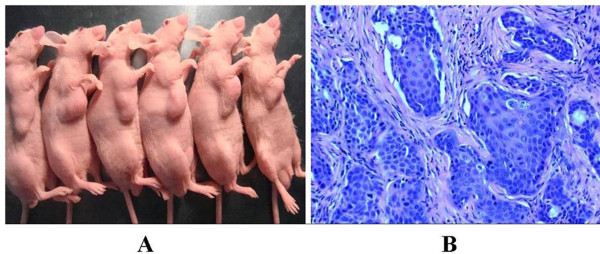
The subcutaneous xenografts of LNCaP cells. A: The nude mice with the subcutaneous xenografts of LNCaP cells were successfully established. The 6 nude mice listed belongs to the group of subcutaneous xenografts of normal LNCaP cells The subcutaneous xenografts can be seen in the oxter of the nude mice. B: The HE staining of these xenografts showed that the typical tumor cells of PCa scattered in clusters or nests with the enlarged and atypia nuclei containing prominent nucleoli which were isolated by redudant tumor-stroma.